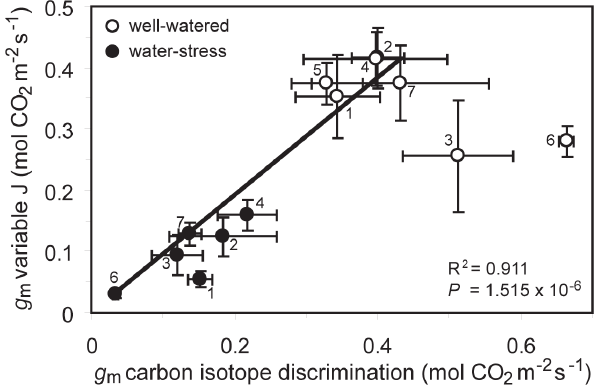
Figure 2. Comparison between the estimates of mesophyll conductance of CO 2 ( g m ) obtained by applying two indepen- dent methods: the variable J method and the ‘ d 13C of recently synthesised sugars’ method (linear regression: R 2 =0.932; F 1,9 =122.750; P =1.515 6 10 2 6 ). Each data point represents the average value of three observations based upon the D 13C of recently synthesised sugars and six to fourteen gas-exchange measurements utilising the variable J method. Error bars as in Figure 1. The regression line excludes the two data points on the right of the graph (IR64 and PS80) with anomalously high g m derived from the d 13C of recently synthesised sugars. Numbers next to data points indicate Oryza sativa variety as in Figure